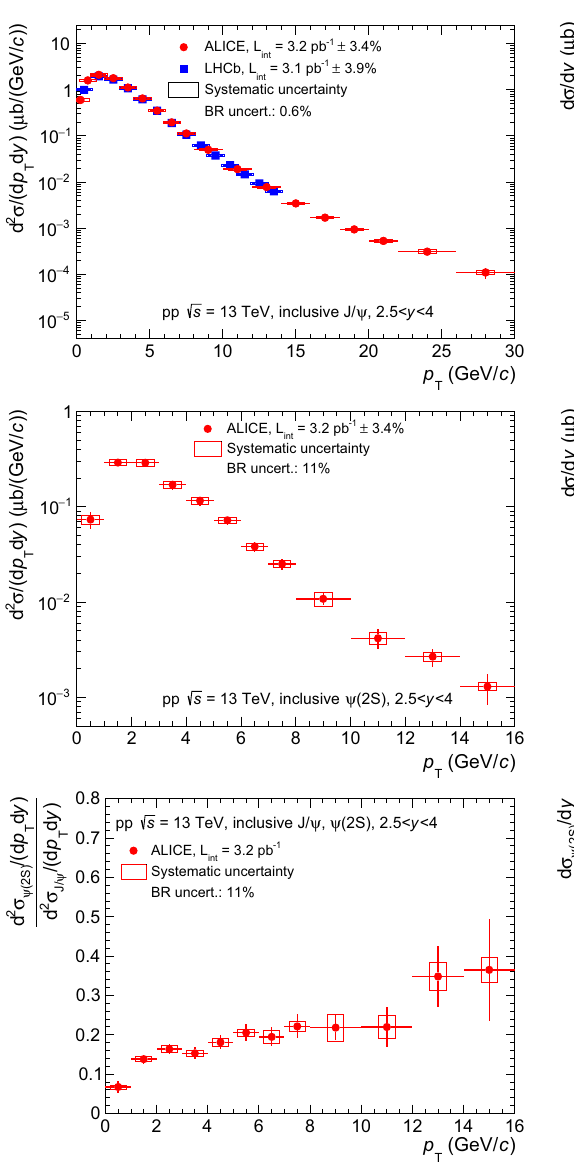
Fig. 2 Inclusive J /ψ cross sections ( top ), ψ( 2S ) cross sections ( mid- dle ) and ψ( 2S ) -to-J /ψ cross section ratios ( bottom ) as a function of p t ( left ) and y ( right ) in pp collisions at